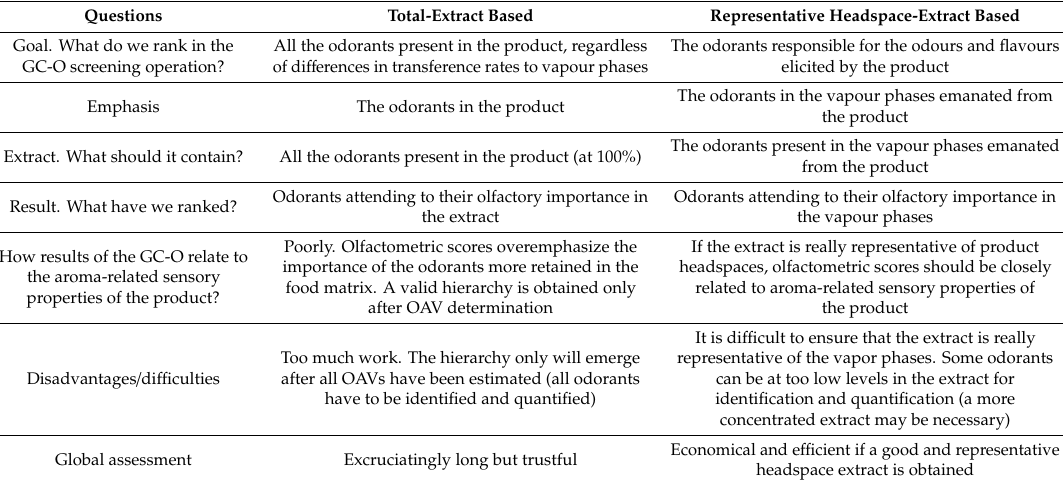
Table 2. The two di ff erent general approaches to GC-O screening